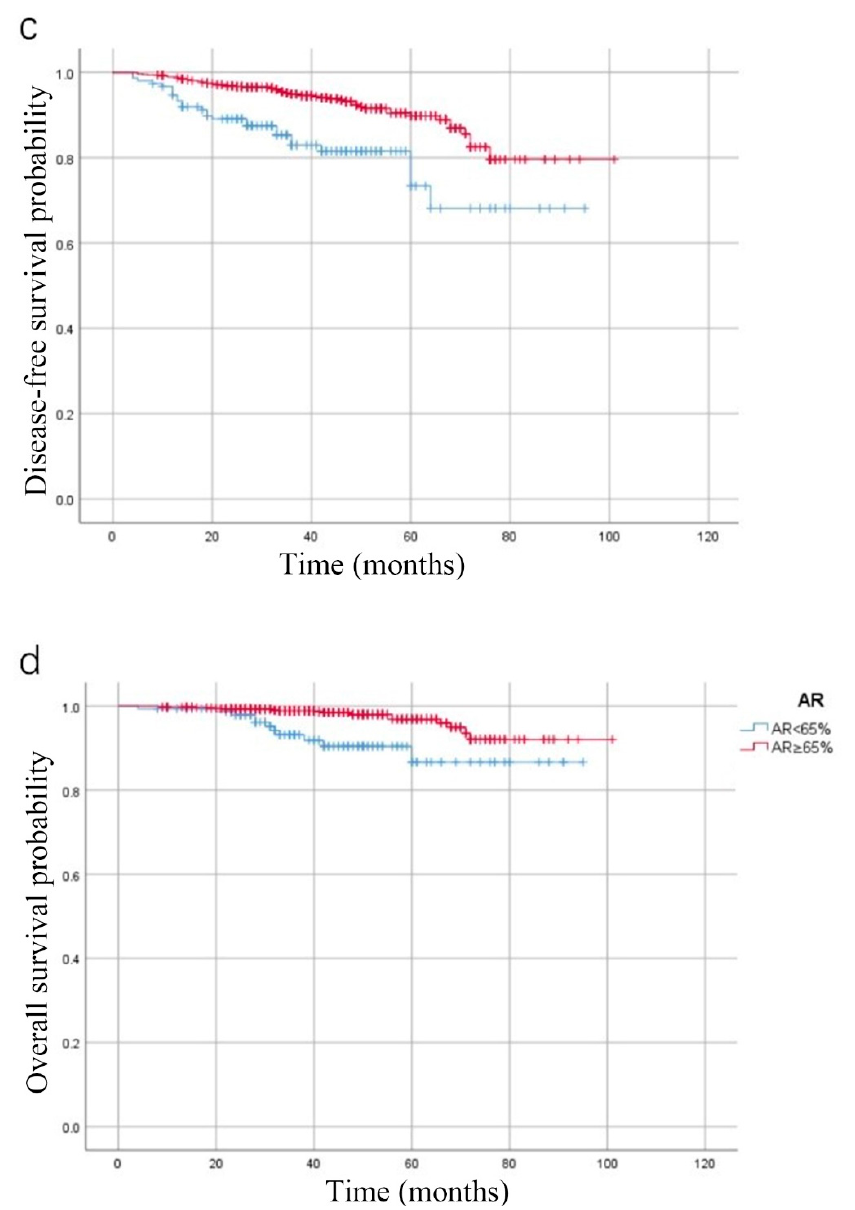
Figure 2. Prognosis of AR and early–stage luminal B breast cancer. ( a ) ROC curve of AR for predicting recurrent metastatic events; ( b ) ROC curve of AR for predicting mortality events; ( c ) Kaplan–Meier analysis of DFS; ( d ) Kaplan–Meier analysis of OS. AR, androgen receptor; DFS, disease–free survival; OS, overall survival.